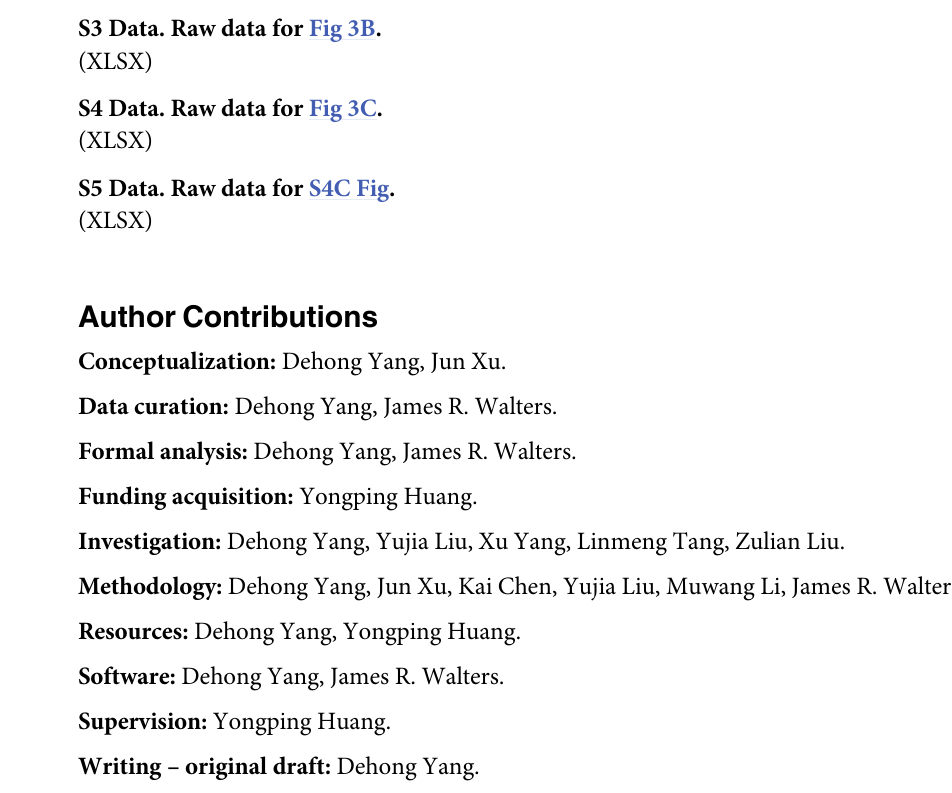
S3 Data. Raw data for Fig 3B. (XLSX) S4 Data. Raw data for Fig 3C. (XLSX) S5 Data. Raw data for S4C Fig.